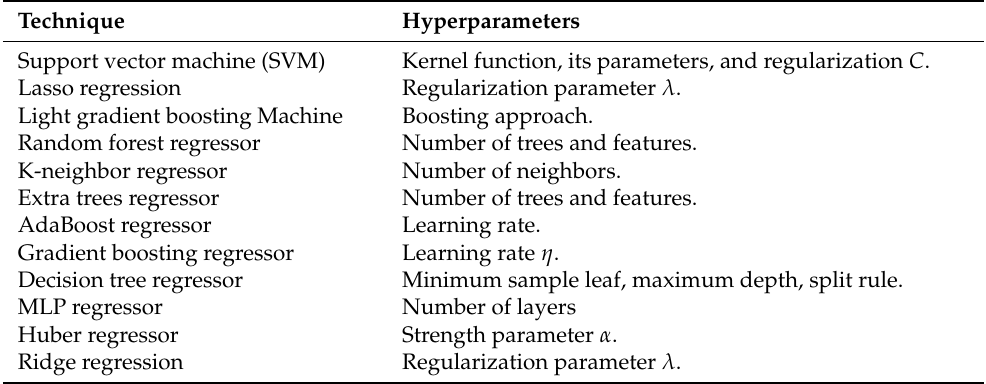
Table 2. The benchmark regression-based approaches used to predict direct and indirect Nitrogen